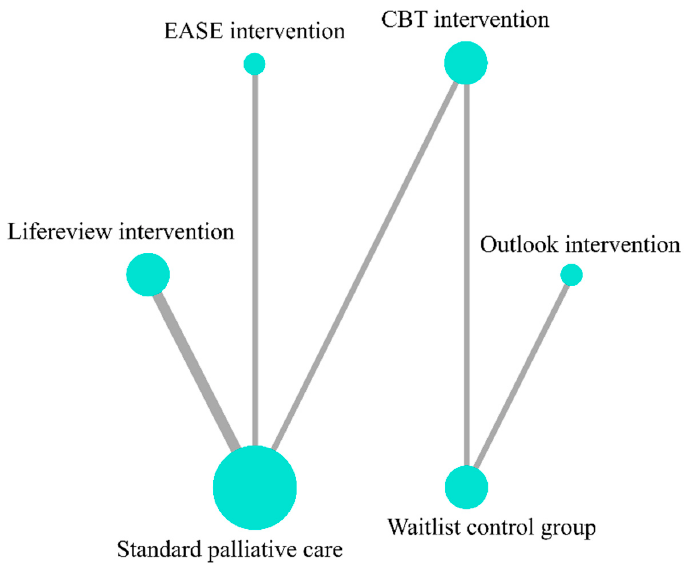
Figure 4. Network plot for outcome of Depression.